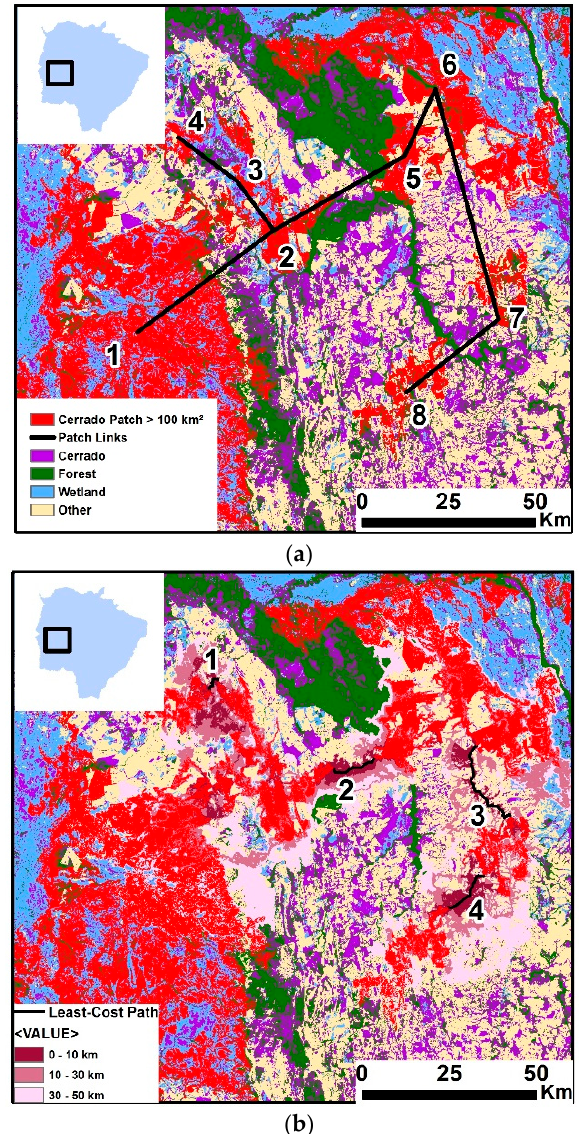
Figure 3. Habitat Connectivity and Least-Cost Path Analysis. ( a ) Habitat connectivity; ( b ) least-cost paths.